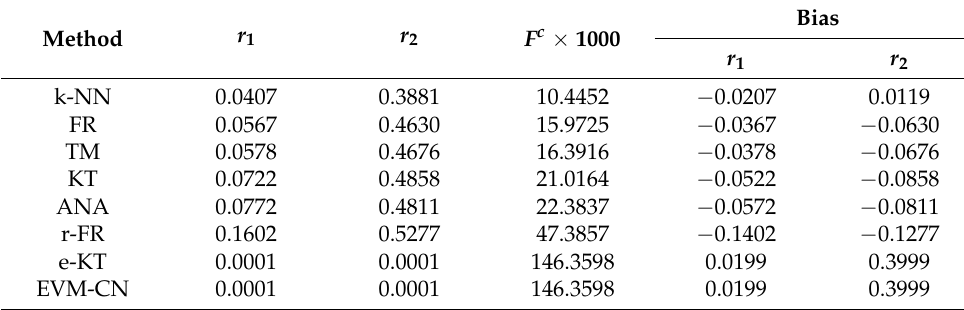
Table 18. Reactivity ratios obtained in the imposed conditions of HC1.